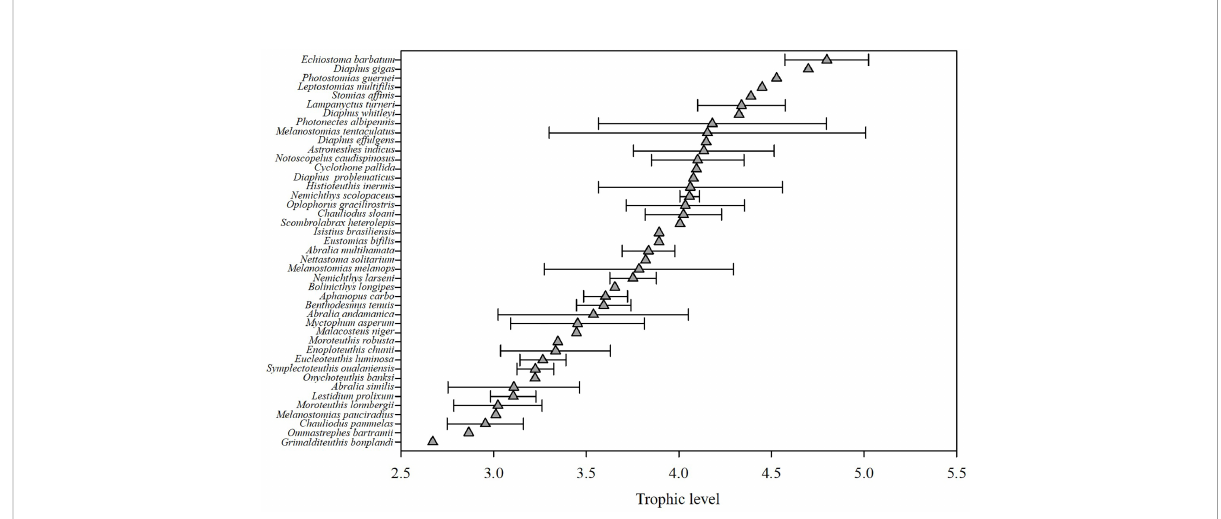
FIGURE 2 Trophic level of micronekton in the Northwest Paci fi c Ocean based on bulk d 15 N